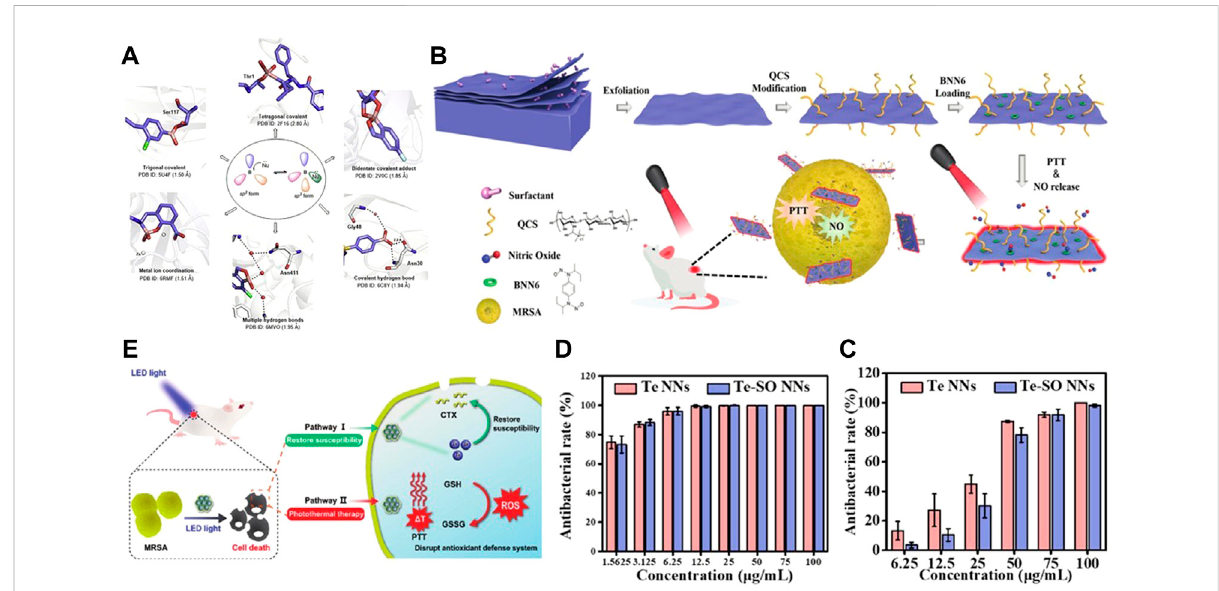
FIGURE 5 (A) Boron compounds and their interaction modes with biological targets. Reproduced from (Song et al., 2021) with permission from Acta Pharmaceutica Sinica B. (B) Preparation of B-QCS-BNN6 and its application in photothermal-NO synergistic antibacterial. Reproduced from (Lv etal.,2022)withpermissionfromBiomaterialsScience.AntibacterialactivityofTeandTe-SOnanoneedles(NNs)toward (C) S.aureus . (D) and E.coli . antibacterial rateinthepresenceofTeand Te-SO NNsatdifferentconcentrations. Reproducedfrom (Huangetal.,2022)with permission